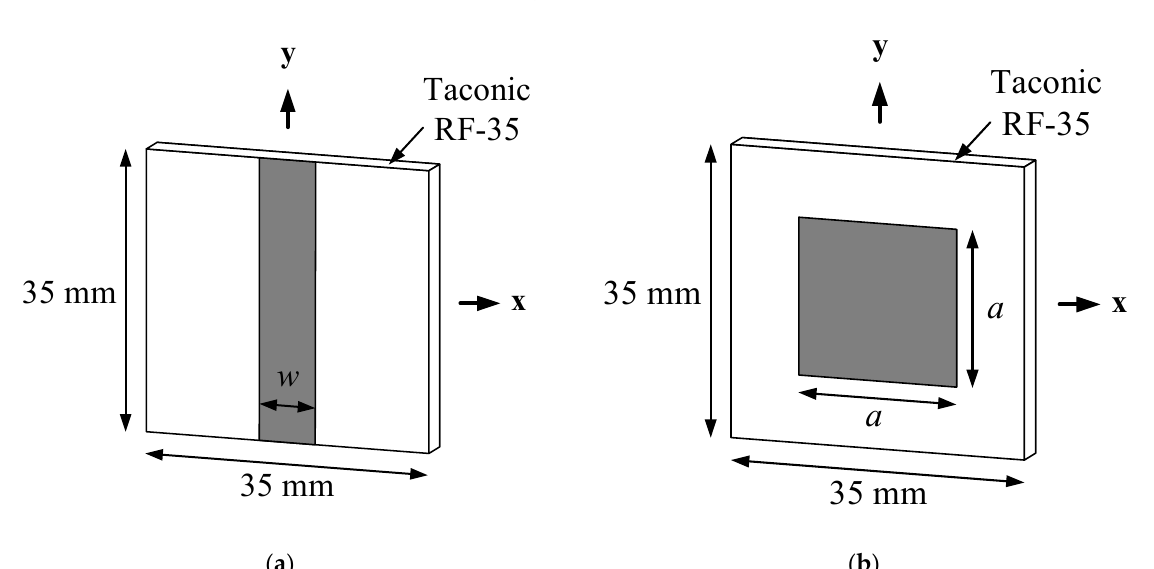
Figure 6. The geometry of each unit cell of ( a ) the PRS and ( b ) the AMC, respectively. Their reflection and transmission coefficients depend on the parameters w and a .